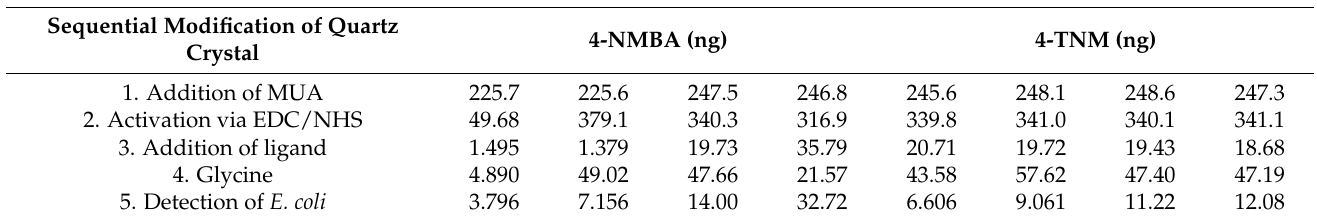
Table 1. Determined masses from each modification step of mannose-derived QCM biosensor to detect E.